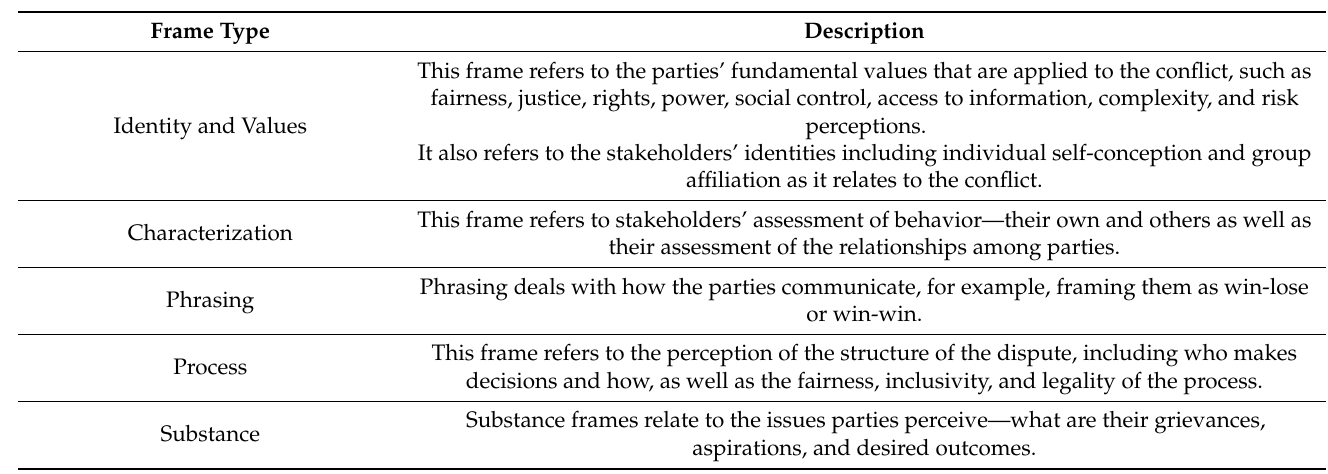
Table 2. Main frameworks (own